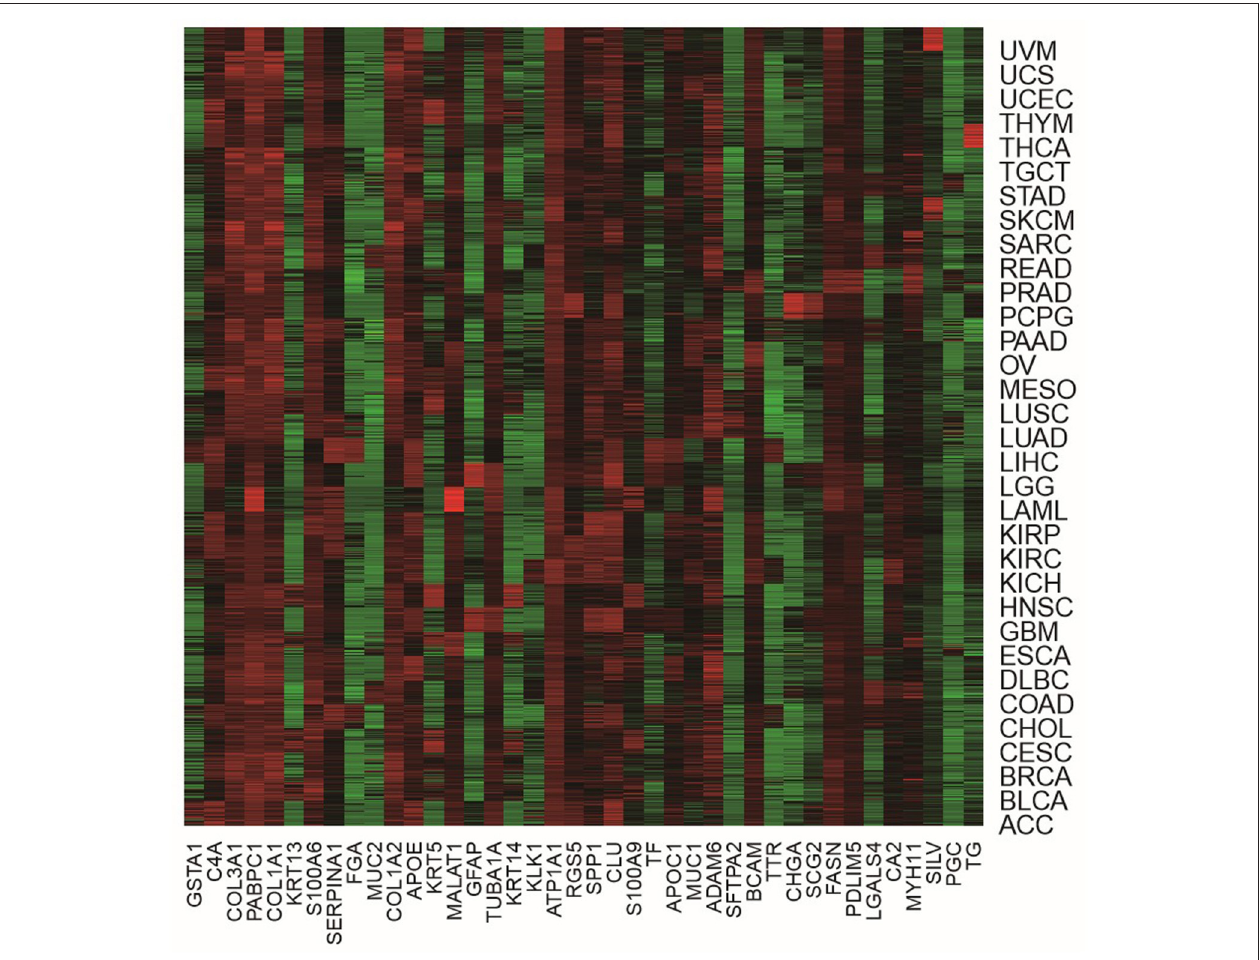
FIGURE 4 | The heat map of the top 40 genes across all tumor